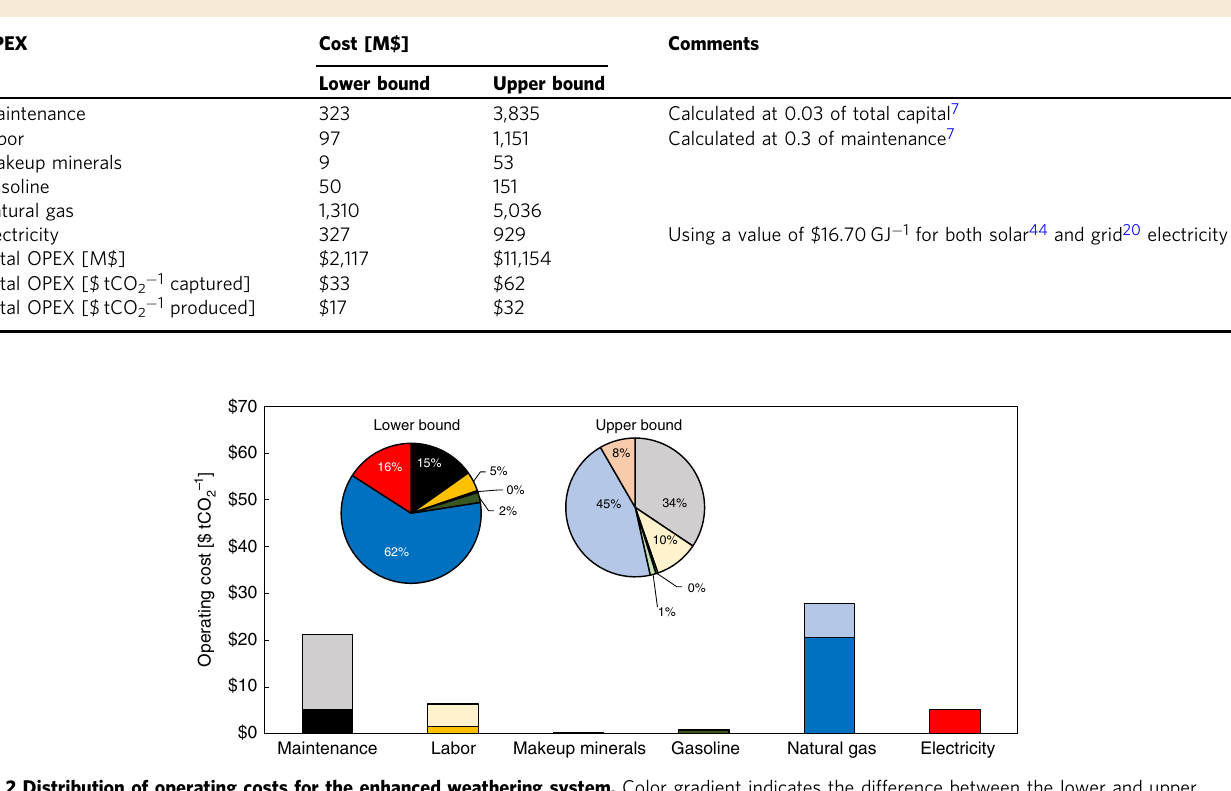
Fig. 2 Distribution of operating costs for the enhanced weathering system. Color gradient indicates the difference between the lower and upper operating cost values. Two pie charts are presented representing the operating cost distribution for both the lower (darker color palette) and upper (lighter color palette) bounds of the analysis. Source data are provided as a Source Data fi